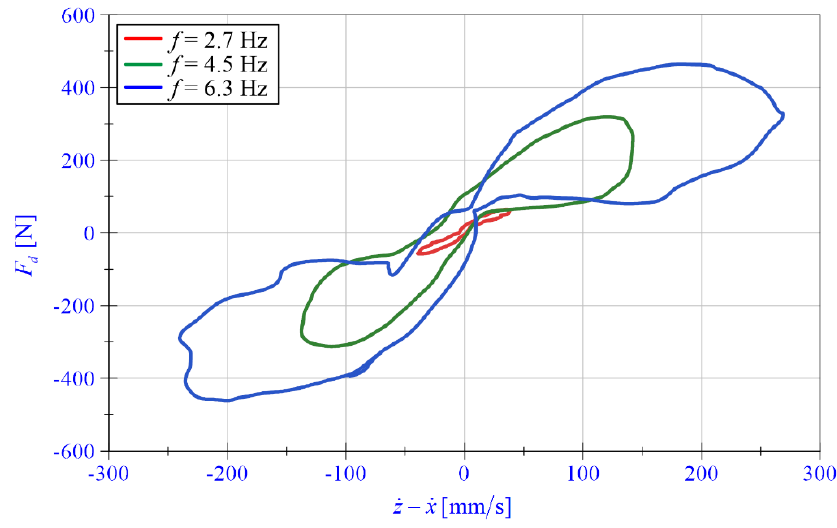
Figure 6. Force-velocity loops (cid:1832) (cid:3031) ((cid:1878)(cid:4662) − (cid:1876)(cid:4662)) Case 2.